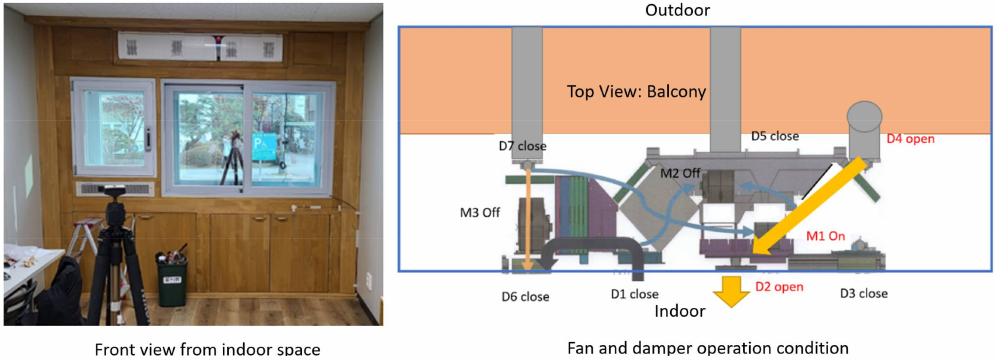
Figure 3. Hybrid air cleaner system and its operating conditions during the